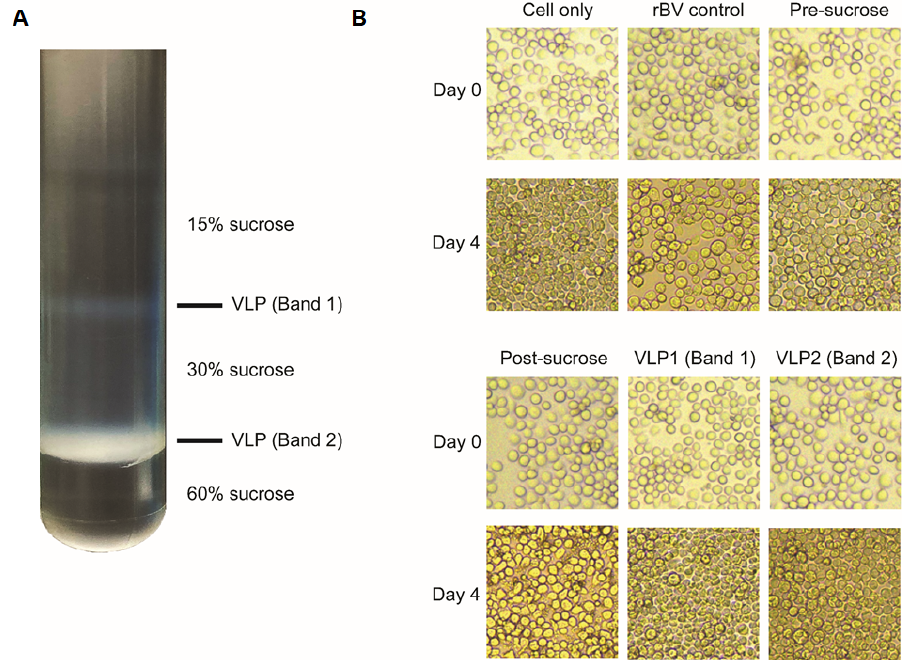
Figure 4. Confirming baculovirus removal after sucrose gradient purification. S full VLPs were used as a representative to confirm baculovirus removal from the VLPs described in this study. Sf9 cells were inoculated with fractions of S full VLPs acquired post-sucrose purification, rBV control, and VLPs before purification (pre-sucrose). Non-inoculated Sf9 cells were used as a negative control. Purified VLPs were labeled as VLP1 (band 1) and VLP2 (band 2) ( A ). Sf9 cells were monitored daily for 4 days to assess baculovirus cell infectivity under the microscope ( B ). All images were acquired at 100x magnification.